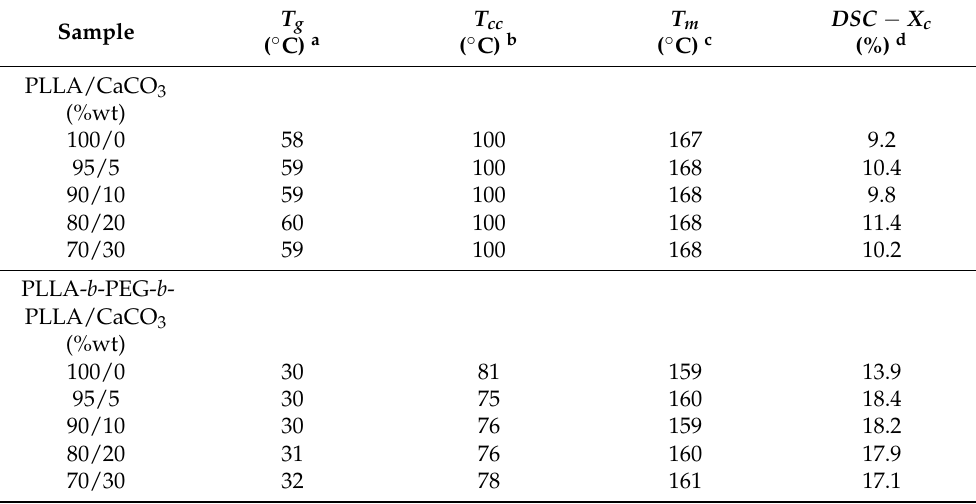
Table 1. Thermal transition properties of the composites from Figure 3. Sample